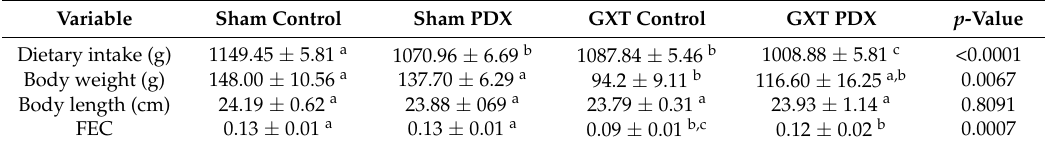
Table 3. Dietary intake, weight, body length and feed efficiency coefficient (FEC) of the animals in the respective experimental groups at the end of the supplementation period.